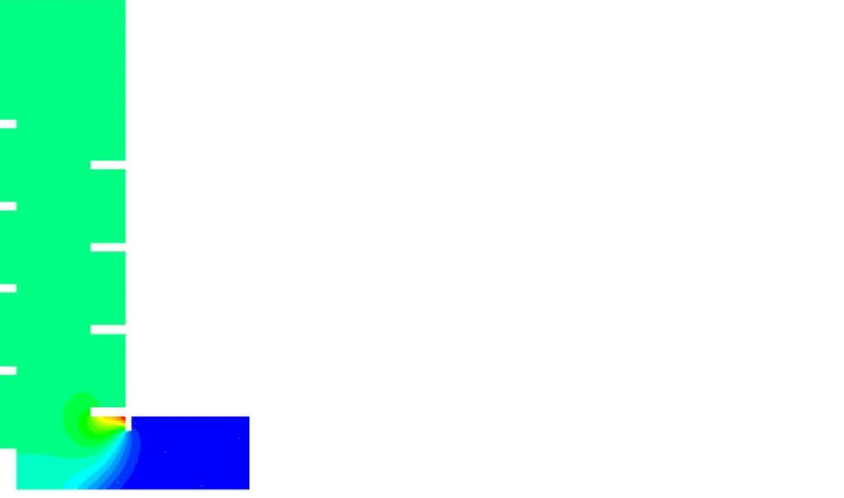
Figure 12. Temperature distribution in the building after axial fan application. Temperature was measured in (K).